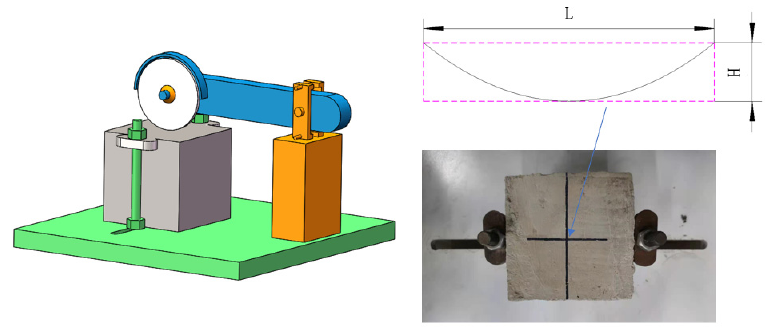
Figure 6. Abrasion-resistance test of concrete after 28 d.